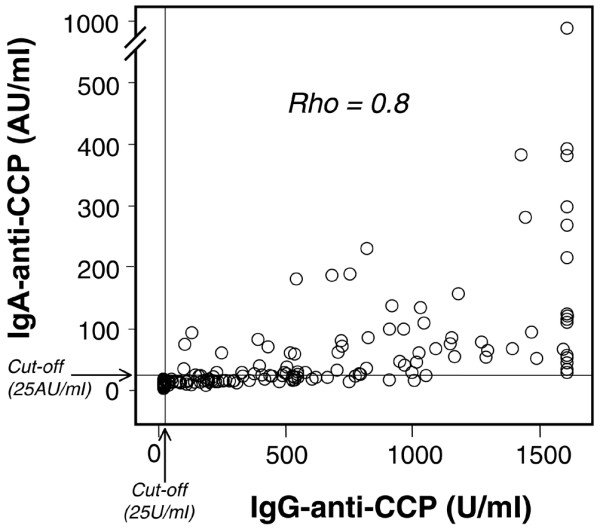
Correlation of IgA-class and IgG-class antibodies against cyclic citrullinated peptides. Correlation between IgG-class antibodies against cyclic citrullinated peptides (IgG anti-CCP) levels and IgA-class antibodies against cyclic citrullinated peptides (IgA anti-CCP) levels in 215 early rheumatoid arthritis sera analysed at inclusion.